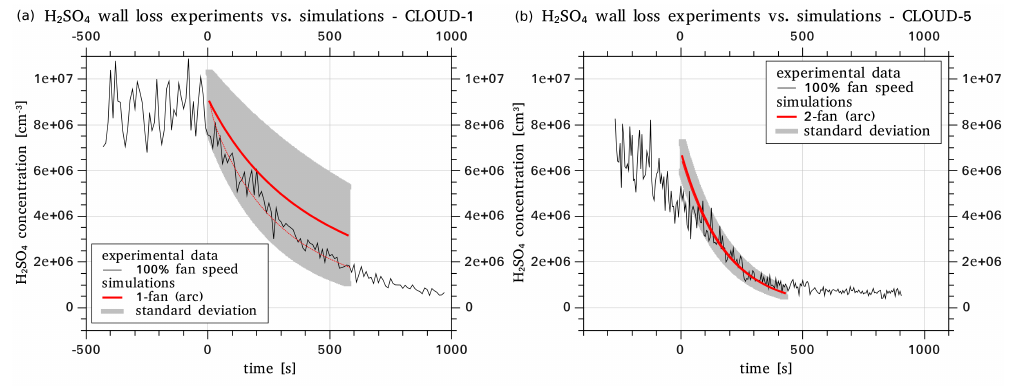
Fig. 6. H 2 SO 4 lifetime experiments compared to numerical simulations for a 1-fan configuration (CLOUD-1, (a) ) and a 2-fan configuration with hoods around the fans (CLOUD-5, (b) ). The blue line for a 2-fan simulation (also arc shaped). The dotted lines are the results at the assumed sampling spot, the solid lines are calculated volume average values. The gray areas standard deviations, calculated for the average values.